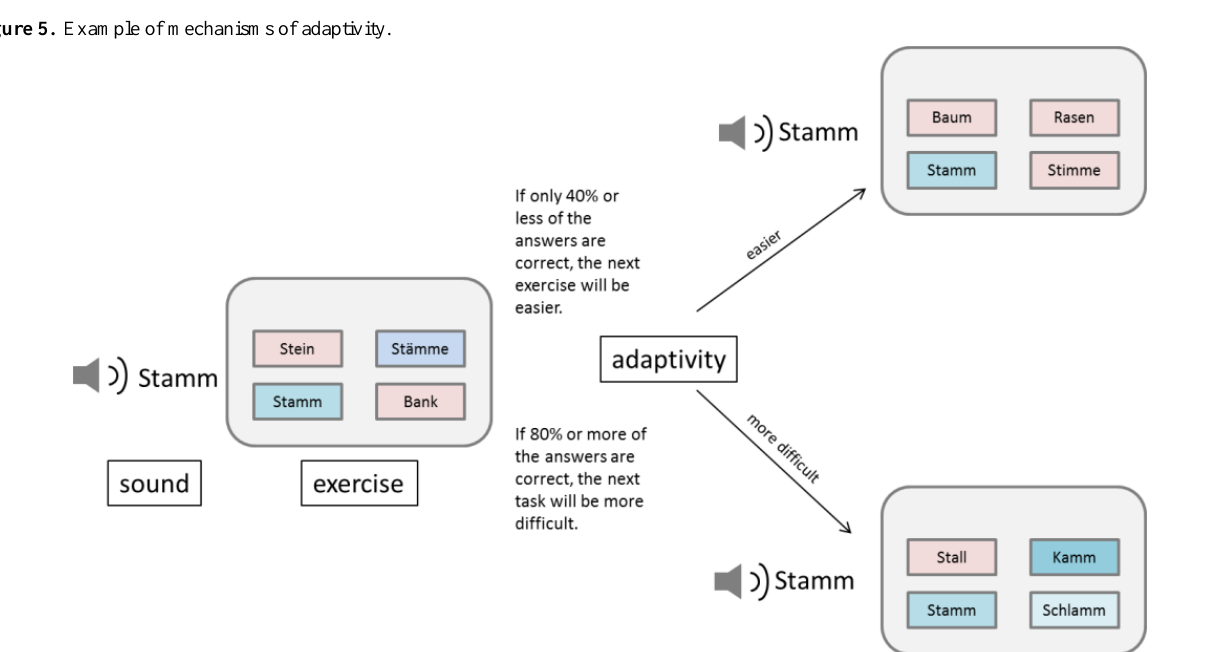
Figure 5. Example of mechanisms of